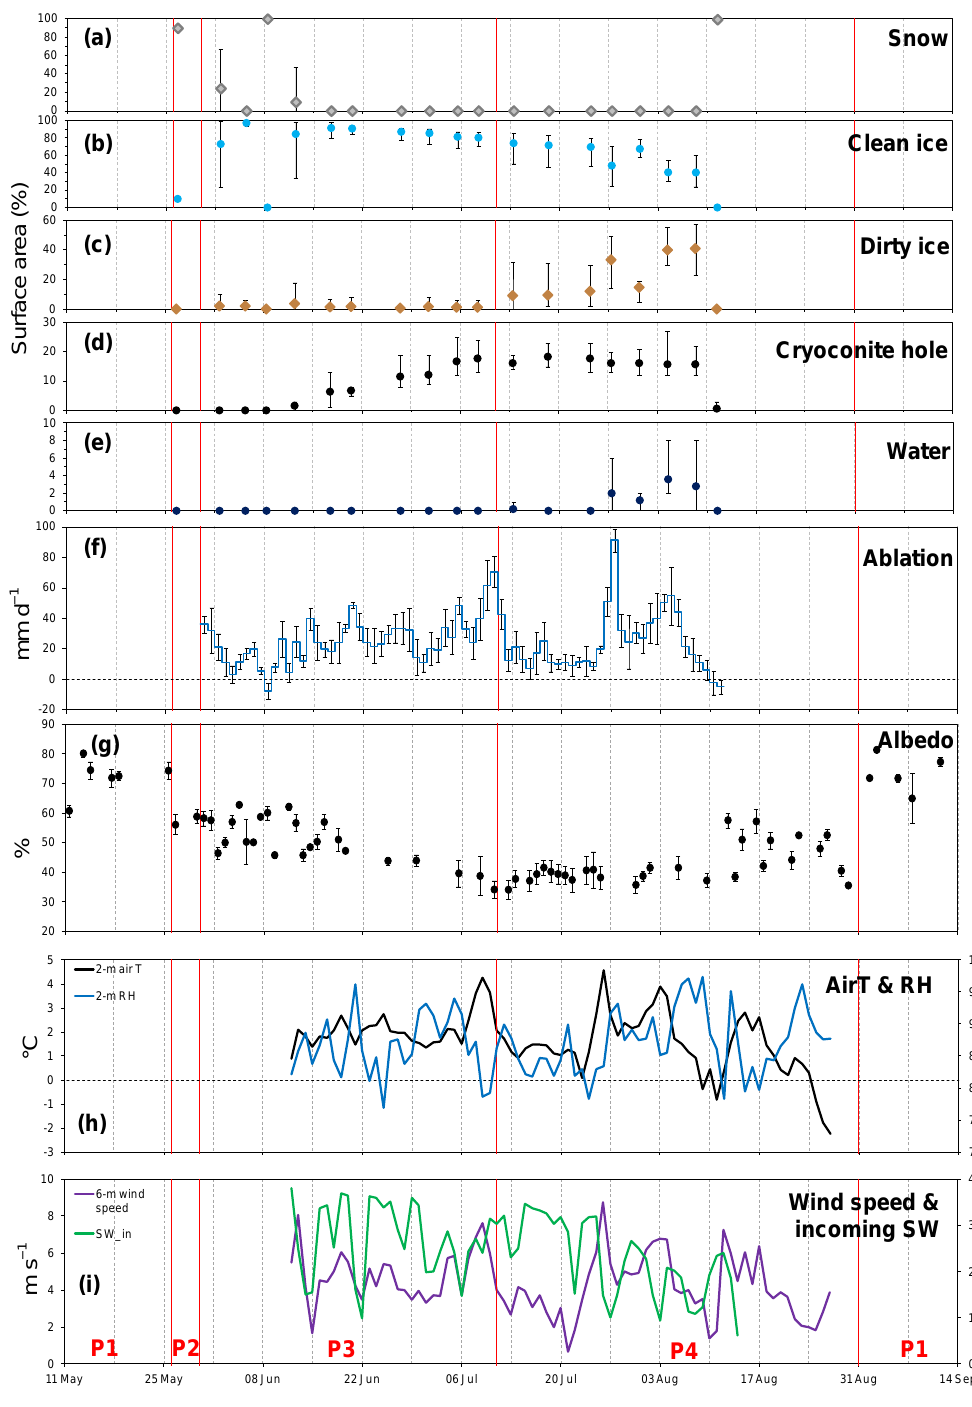
Figure 6. Percentage surface area (SA) covered by (a) snow, (b) clean ice, (c) dirty ice, (d) cryoconite holes and (e) water. Error bars are the range observed in five quadrats. (f) Daily ablation rate showing mean of five measurements (blue line); error bars are ± 1 σ . (g) Daily mean AVHRR-derived surface albedo ± 1 σ . Vertical red lines are approximate boundaries between periods P1 and P4 (see text). (h–i) Daily averages of 2m air temperature, relative humidity, 6m wind speed and incoming short-wave radiation intensity at AWS S6 located 11km from our field